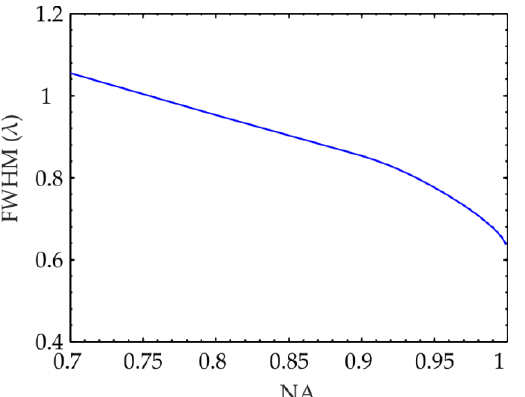
Figure 9. Focal spot diameter at full width at half maximum when focusing an optical vortex ( m = − 1) with circular polarization when focusing with a flat diffractive lens. When the numerical aperture of the lens is approximately equal to NA = 0.93, a flat top is observed at the formed focus (Figure 10), and the focal spot diameter for this case is FWHM = 1.03 λ .